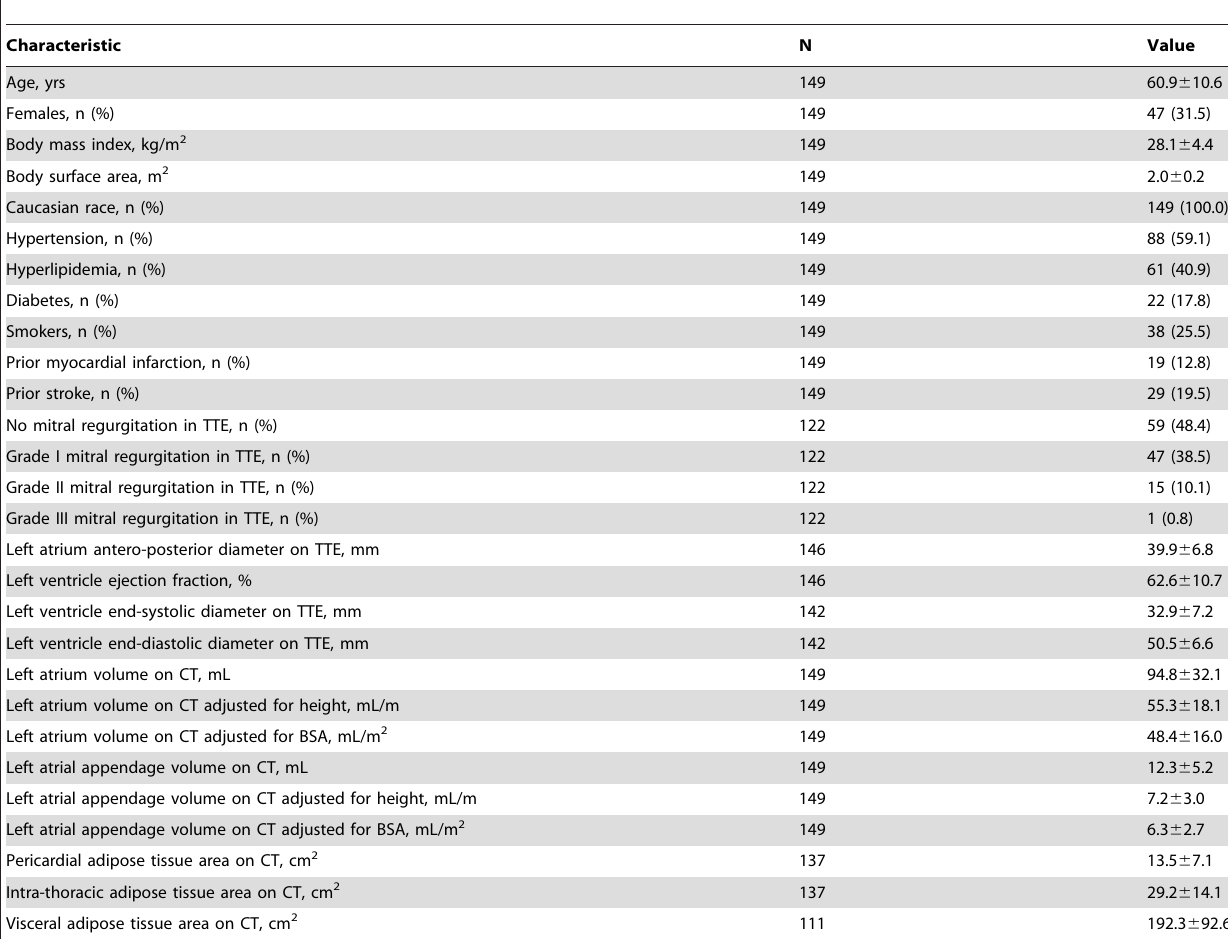
Table 1. Clinical Characteristics of Patients with Suspected Cardioembolic